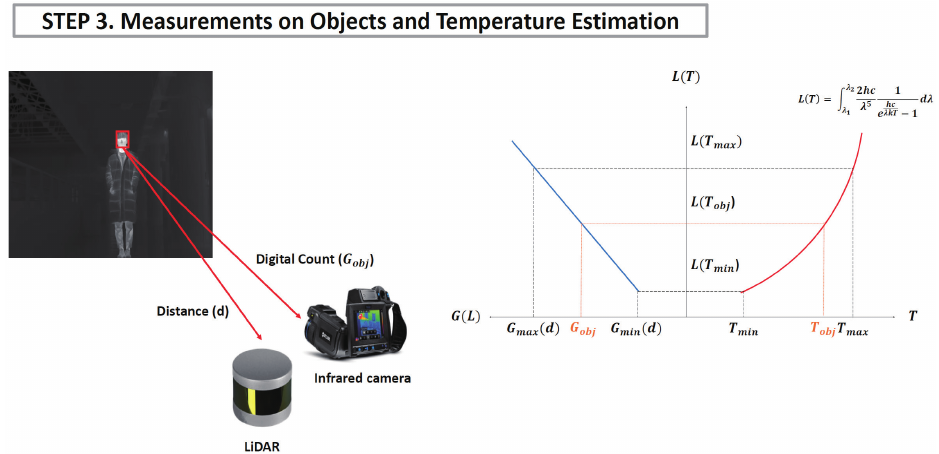
Figure 11. [STEP 3: Measurements of the Objects and Temperature Estimation] Digital count and distance acquisition for objects using an infrared camera and LiDAR, and temperature estimation using a newly defined mapping